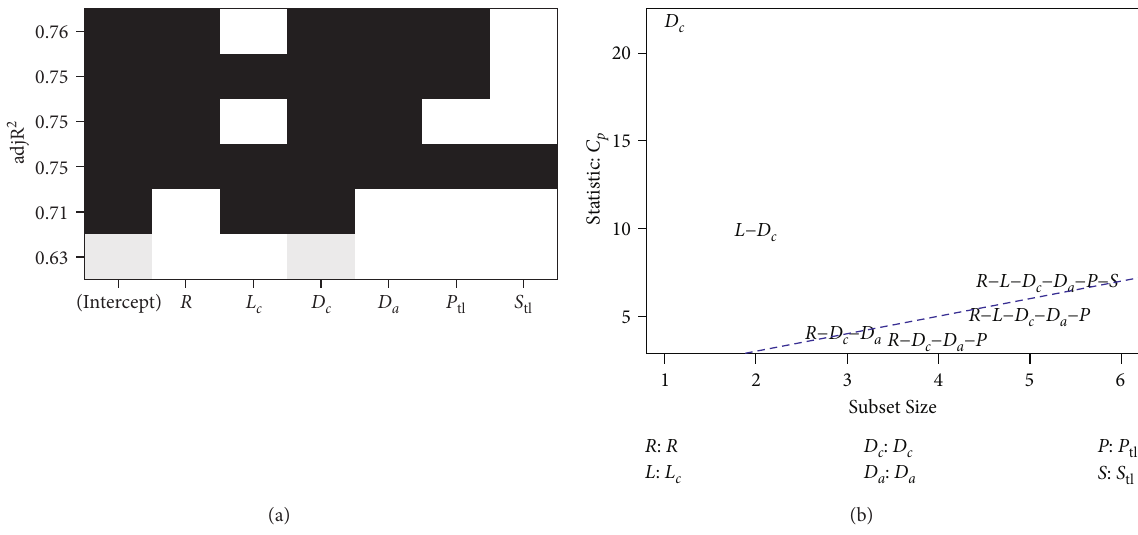
Figure 6: Model selection based on (a) adjusted R -square and (b) C